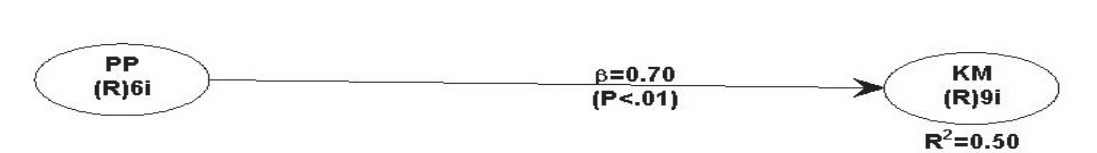
Fig. 3. The results of direct